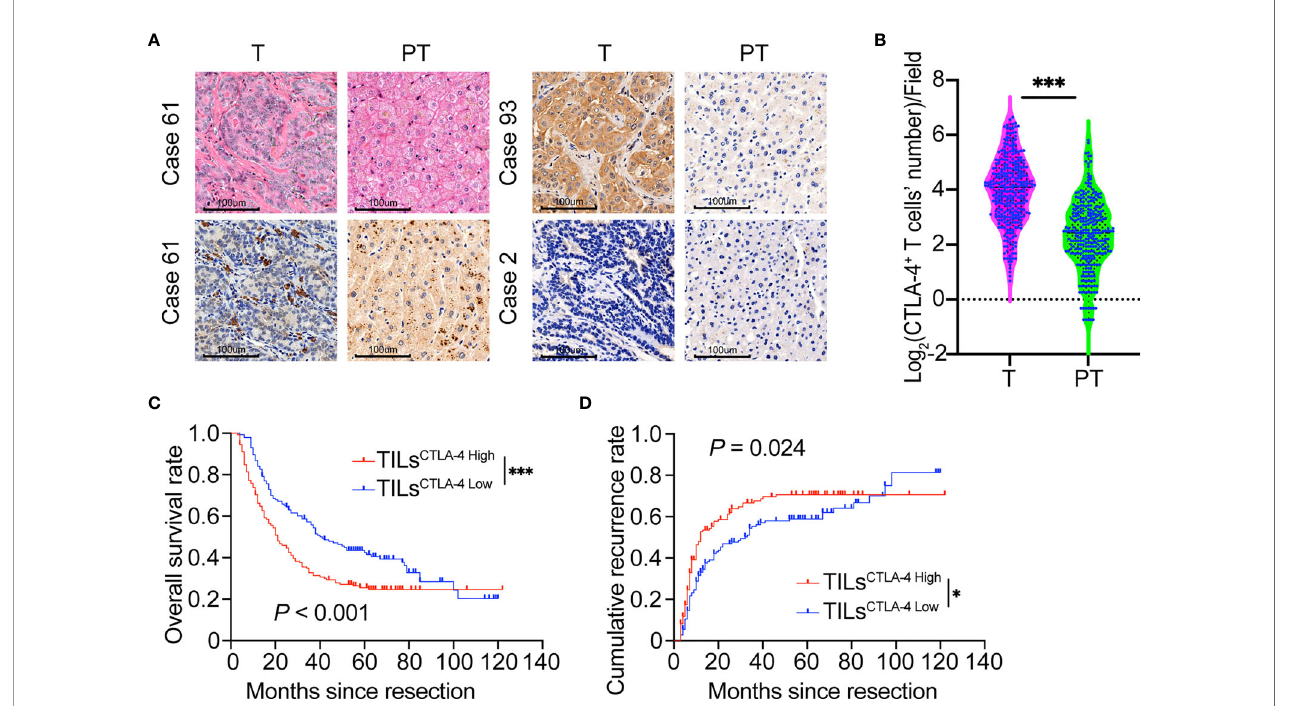
FIGURE 1 | Prognostic implications of CTLA-4 expression in ICC tumors versus paired adjacent normal liver tissues. (A) Representative H&E staining of CTLA-4 in ICC tumor and paired adjacent normal liver tissues (Case 61, CTLA-4 positively stained on tumor-in fi ltrating lymphocytes; Case 93, CTLA-4 positively stained on ICC tumor cells; Case 2, Negative staining on tumor cells or lymphocytes of CTLA-4; T, Tumor; PT, Paired adjacent normal liver tissues). Magni fi cation 200x. (B) Density of CTLA-4 + in fi ltrating lymphocytes was higher in ICC tissues than paired adjacent normal liver tissues in the whole ICC cohort ( P <0.001, paired Student ’ s t- test). (C, D) The Kaplan – Meier curve of OS and cumulative recurrence shows that patients with TILs CTLA-4 High were associated with worse OS and a higher cumulative recurrence rate compared with patients with TILs CTLA-4 Low . * P < 0.05 and *** P <